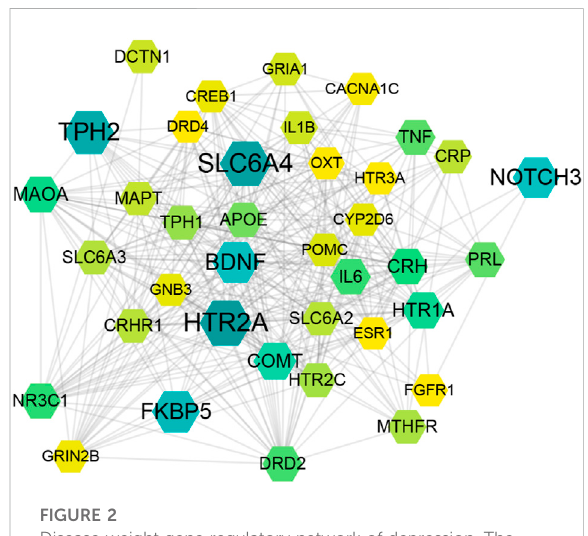
FIGURE 2 Disease weight gene regulatory network of depression. The size and color of the node represents the relevance score of